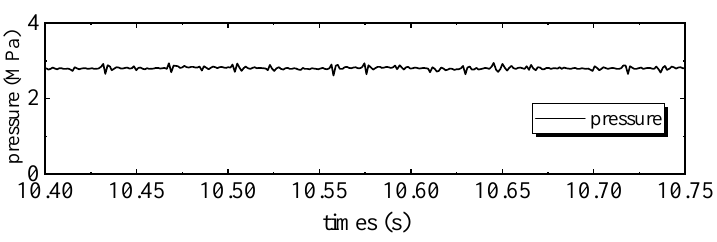
Figure 8. ARC tracking errors of two motors.